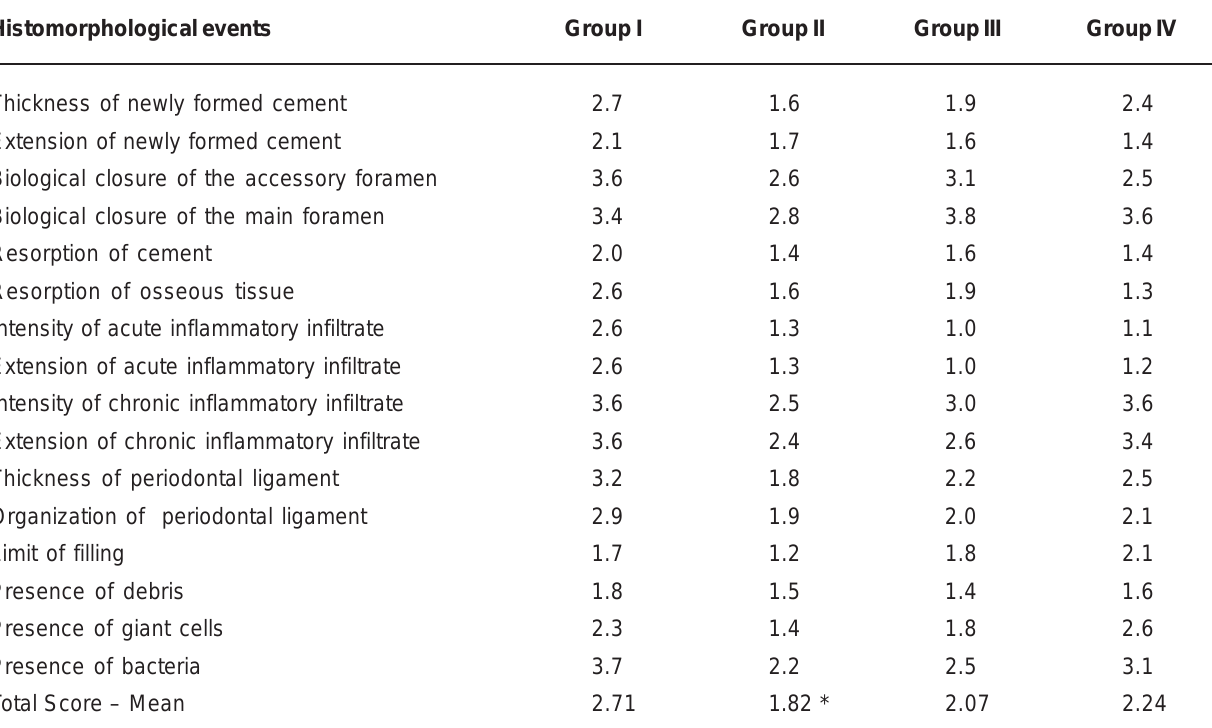
* Statistical significant level ( α =0.01)